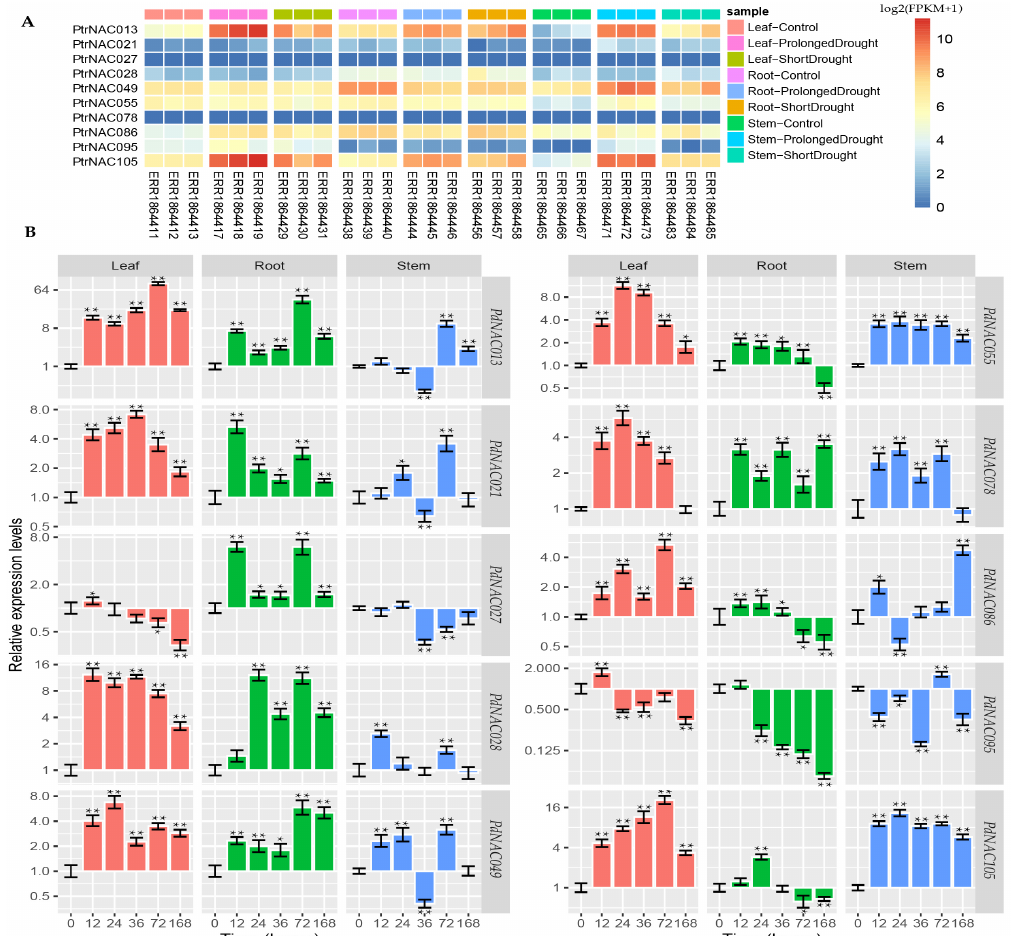
Figure 6. ( A ) Heatmap analysis of ten PtrNAC genes under drought stress. The expression value for ten PtrNAC genes was calculated by log2 (RPKM+1) and represented by color scale. ( B ) Tissue-specific expression patterns of ten PdNAC genes in poplar under drought stress. The Y-axis indicated the relative expression level. The X-axis represented hours (0, 12, 24, 36, 72 and 168) after drought treatment inseedlings of the poplar NL895. The β -actin gene (Potri.019G006700.1) was used as an internal control. The error bars were obtained from three biological replicates. The asterisks indicated that genes were significantly up-regulated or down-regulated in NL895 poplar under drought stress, according to t-test (*, p < 0.05; **, p < 0.01).